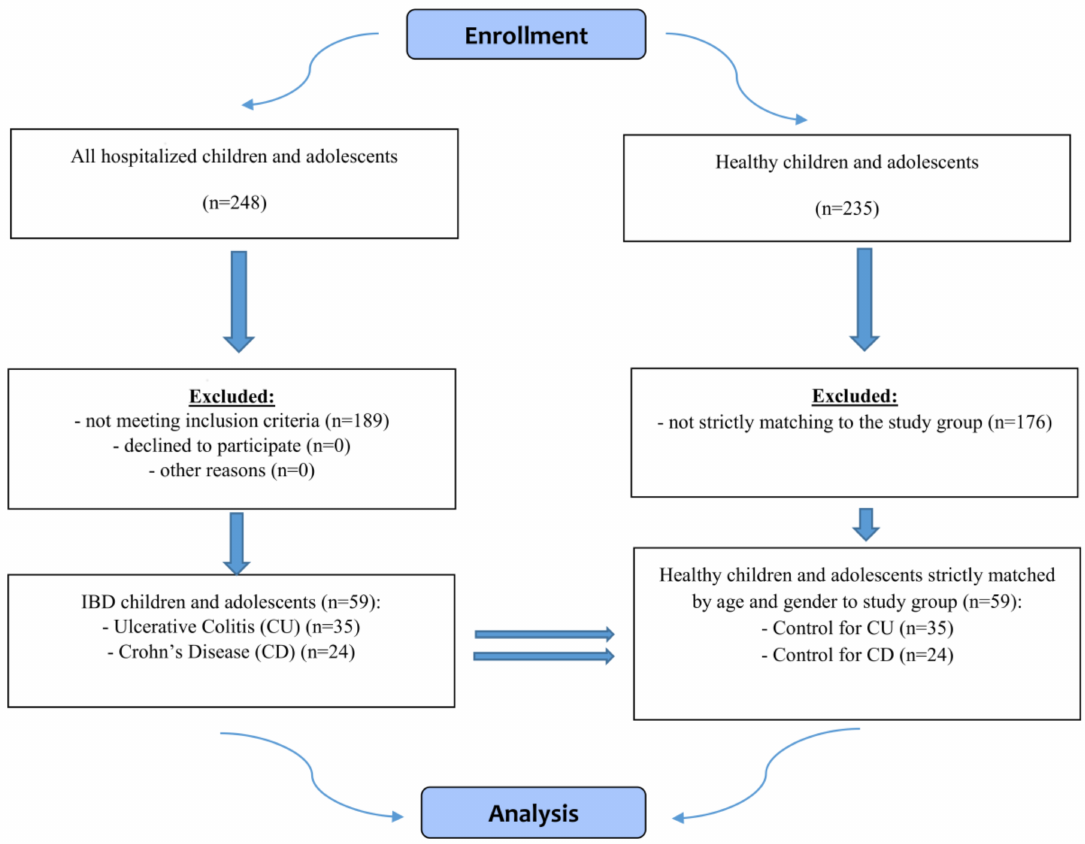
Figure 1. Flow chart demonstrating study participants selection. Table 1. Demographic and anthropometric parameters of the study